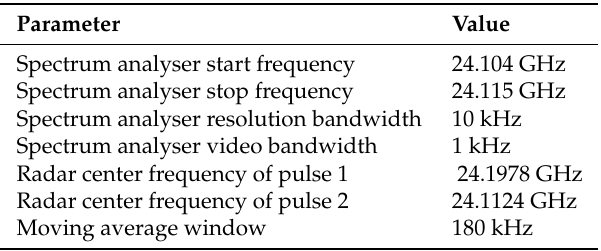
Table 3. Parameters of the